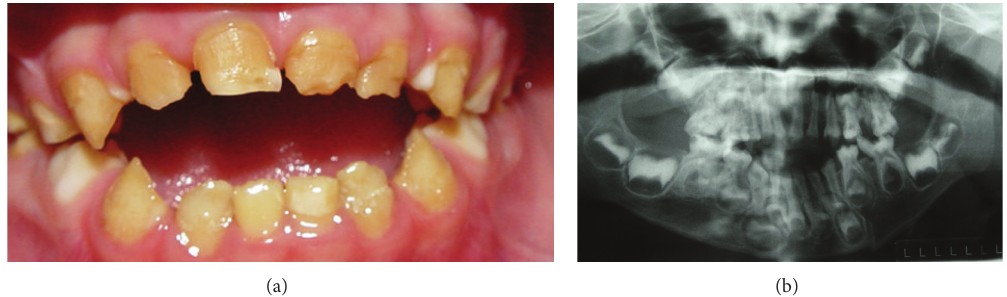
Figure 2: (a) Frontal view of amelogenesis imperfecta; (b) panoramic radiography before